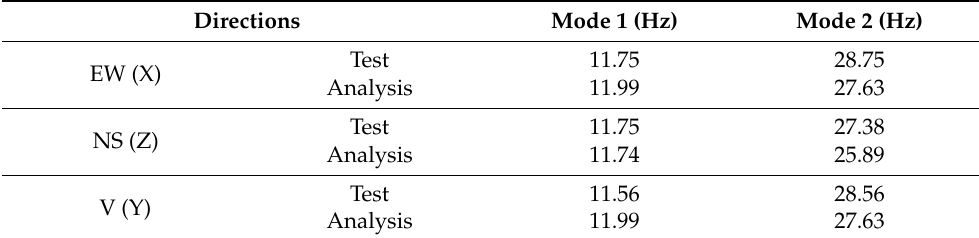
Figure 13. Resonance test results for each direction: ( a ) EW (X); ( b ) NS (Z); ( c ) vertical (Y). Table 8. Comparison of resonance frequencies between tests and